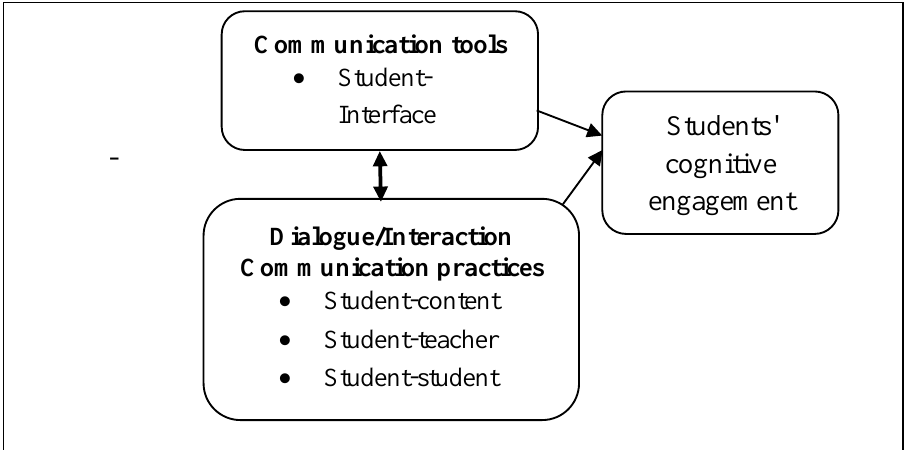
Figure 1 . Hypothesized model for communication management in Distance Learning